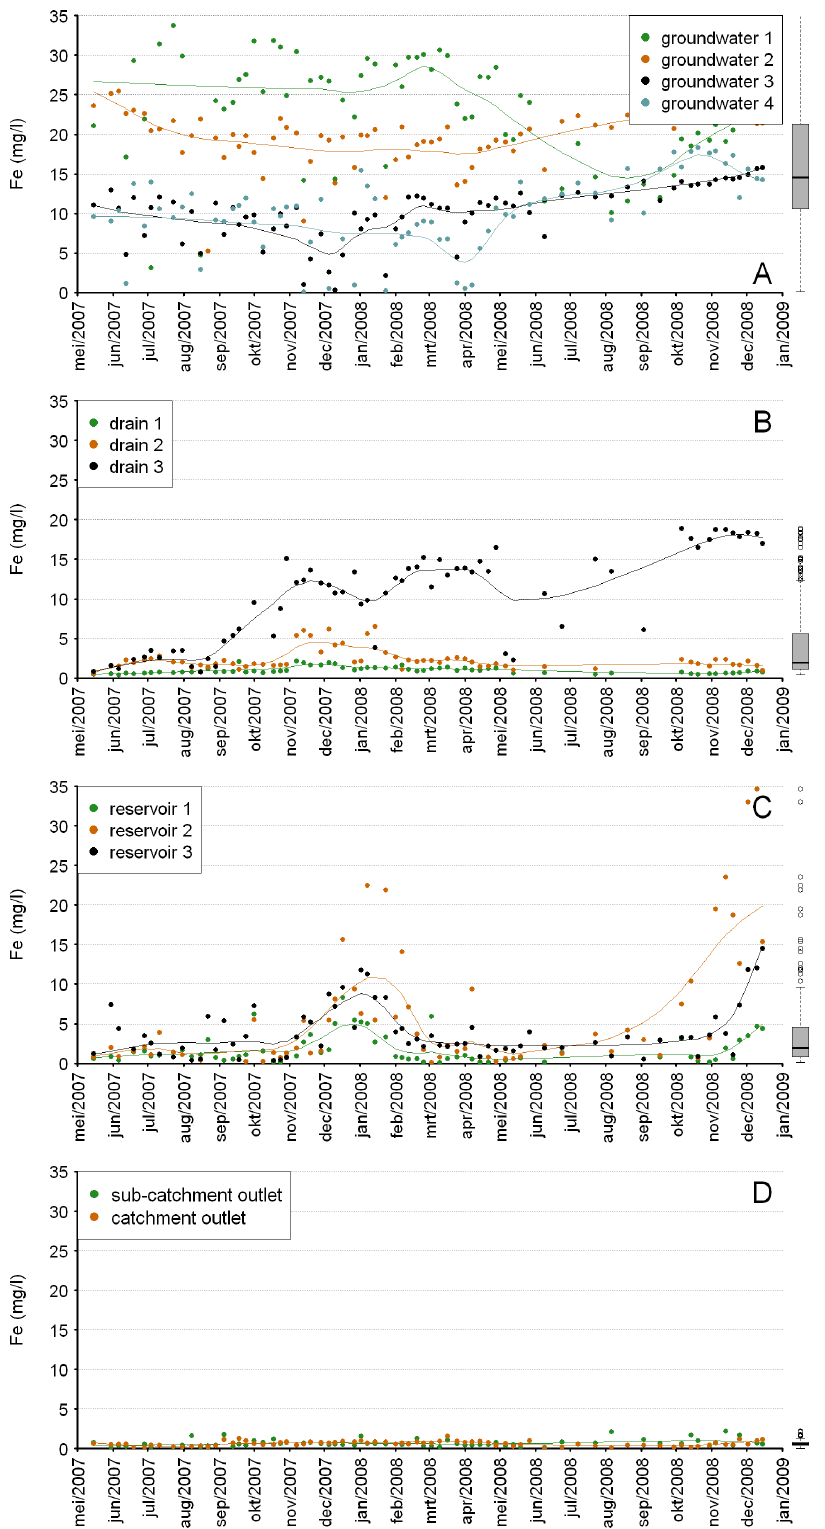
Figure 2. Time series and boxplots of Fe concentration of groundwater (a) , tube drain water (b) , in-stream reservoir water (c) and surface water (d) . The smoothing line through the measured data points is calculated with the method of Friedman (1984). The bold solid line within each box plot is the median concentration. The lower and upper side of the box represents the 0.25 and the 0.75 quantile. Whiskers extend to the maximum and minimum value unless the values are larger then 1.5 times the box length. Open circles are extreme